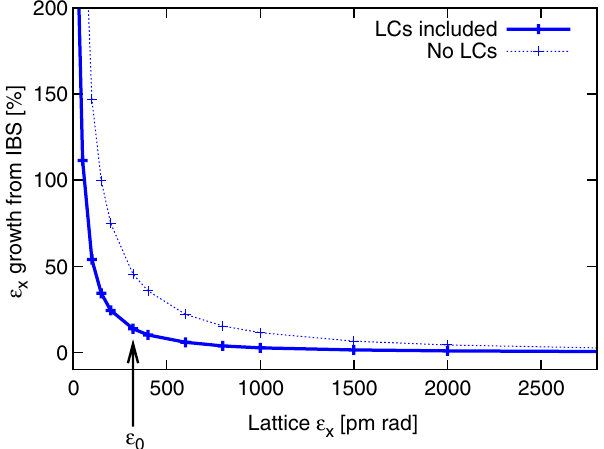
FIG. 2. Horizontal emittance growth caused by IBS at 500 mA stored current as a function of lattice emittance. It is assumed the latter can be adjusted freely while keeping the energy spread constant. The overall MA has been set to 4.5% and the vertical emittance is always adjusted to 8 pm rad. The effect of the LCs is shown. The equilibrium emittance ε 0 of the MAX IV 3 GeV storage ring bare lattice is